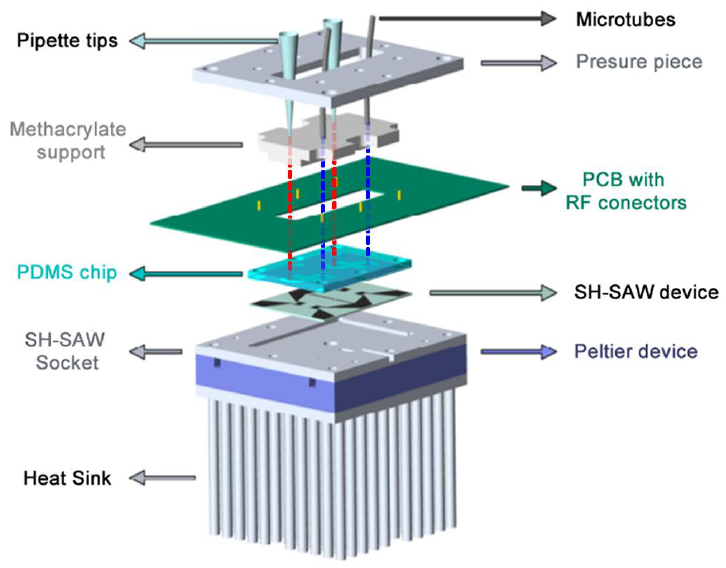
Figure 2. Liquid cell diagram showing the different components.